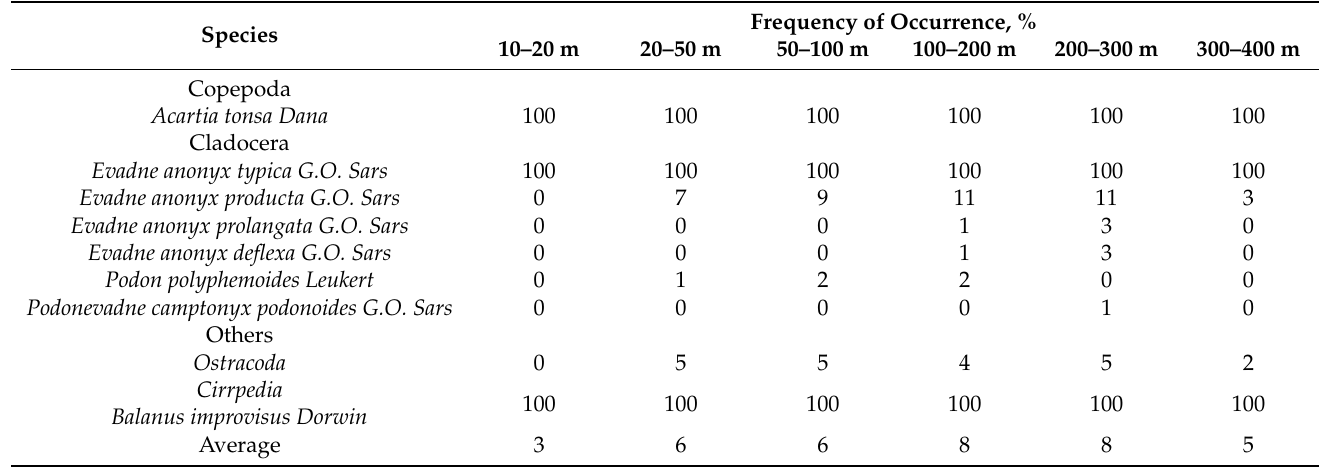
Table 6. Species composition and frequency of occurrence of zooplankton in the eastern part of the Middle Caspian, May